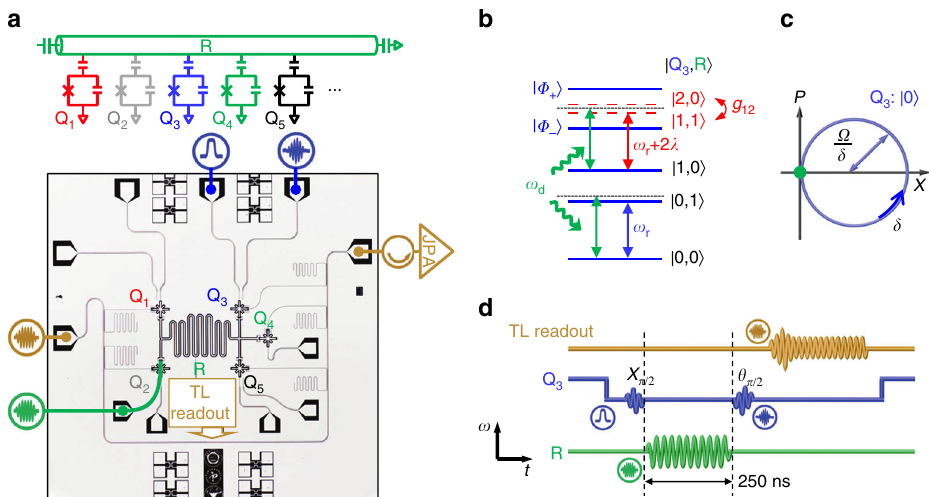
Fig. 1 Device and scheme for measuring geometric phase. a Device schematic and image illustrating the fi ve frequency-tunable qubits, labeled from Q 1 to Q 5 , and the bus resonator R, which has a fi xed bare frequency (resonator frequency in absence of qubits) ω rb /2 π ≈ 5.585GHz. The color-coded icons identify the pads where pulses are injected onto the circuit chip. The transmission line (TL) carries the multi-tone microwave pulse through the circuit chip, which is ampli fi ed by a Josephson parametric ampli fi er (JPA) at low temperature and then demodulated at room temperature to yield the state of all qubits. b Energy level con fi guration of the qubit-resonator system. The strong coupling between 2 ; 0 j i and 1 ; 1 j i produces the dressed states ϕ ± levels are well separated. A microwave drive with a tone of ω d that is slightly detuned from ω r by δ can or cannot excite the resonator depending on whether the qubit is in the state 0 j i or 1 j i . c Resonator ’ s phase-space displacement conditional on the qubit state 0 j i . In the drive frame, the resonator, initially in its ground state, is displaced by the microwave drive of an amplitude Ω along a circle in phase space with the radium Ω / δ and the angular velocity δ conditional on the qubit state 0 j i . At time T = 2 π / δ , the resonator makes a cyclic evolution, returning to the ground state, but acquires a conditional geometric phase proportional to the enclosed phase-space area. d Ramsey interference sequence plotted in the frequency vs. time plane. The geometric operation, resulting from the combination of the microwave drive (green sinusoid) and the qubit-resonator coupling, is sandwiched in between the two π /2 rotations (blue sinusoids with Gaussian envelopes), X π /2 and θ π /2 , whose rotation axes are in the xy plane of the Bloch sphere and differ by an angle of θ . The corresponding geometric phase β is revealed by measuring the qubit 1 j i -state probability as a function of θ , using the microwave pulse through the TL readout line (light brown sinusoid with a ring-down shape at the